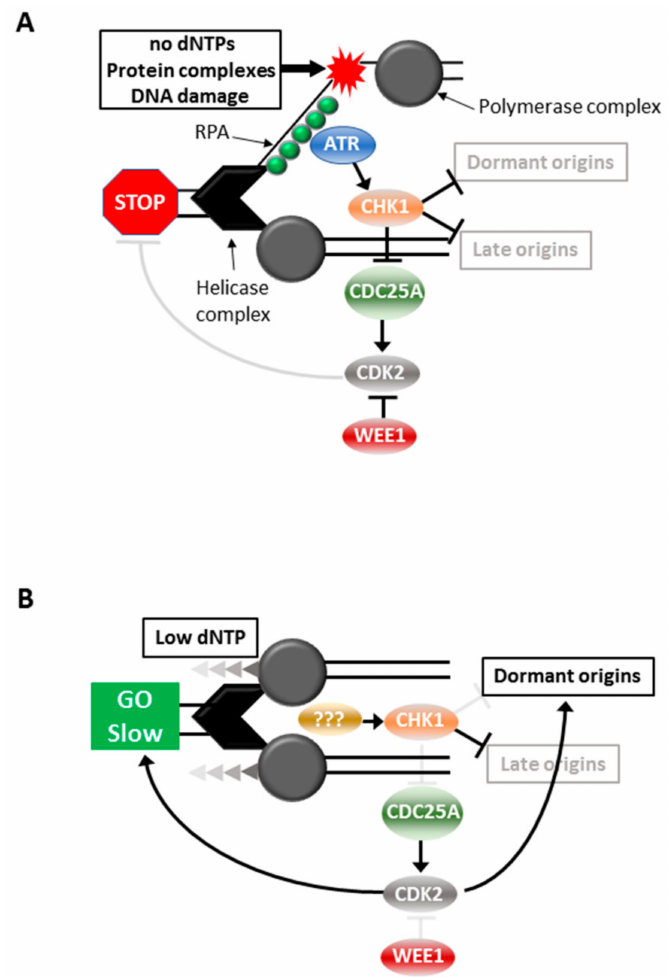
Figure 1. Responses to replication stress. Cell cycle responses to high ( A ) and moderate ( B ) replication